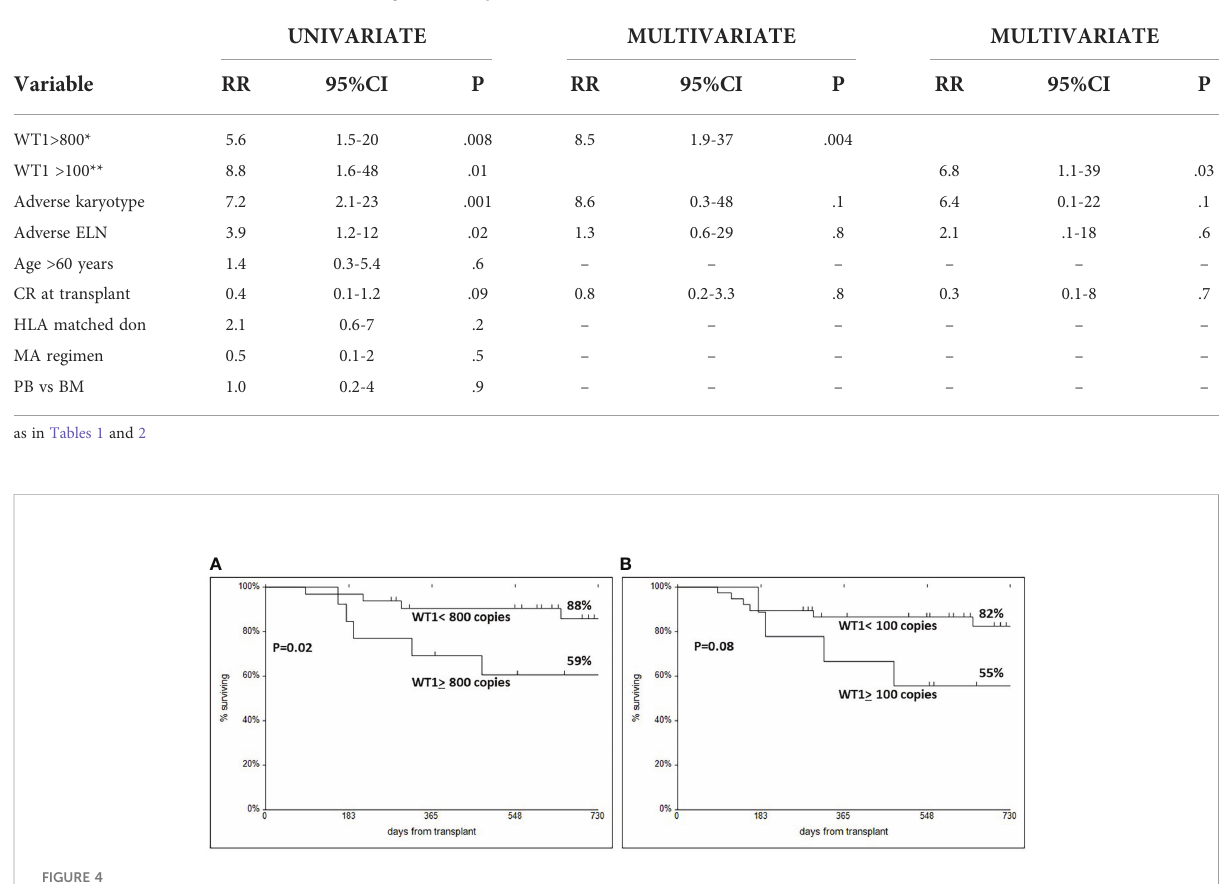
TABLE 3 Univariate and multivariate Cox analysis on